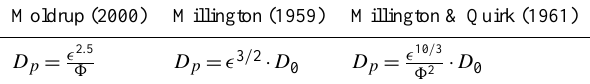
Table 1. Mathematical formulations for the calculation of the ef- fective diffusion coefficient in soil. (cid:15) is the soil air-filled poros- ity in m 3 (soil air) m − 3 (soil), 8 is the soil total porosity in m 3 (pores) m − 3 (soil) and D 0 is the gas diffusion coefficient in free